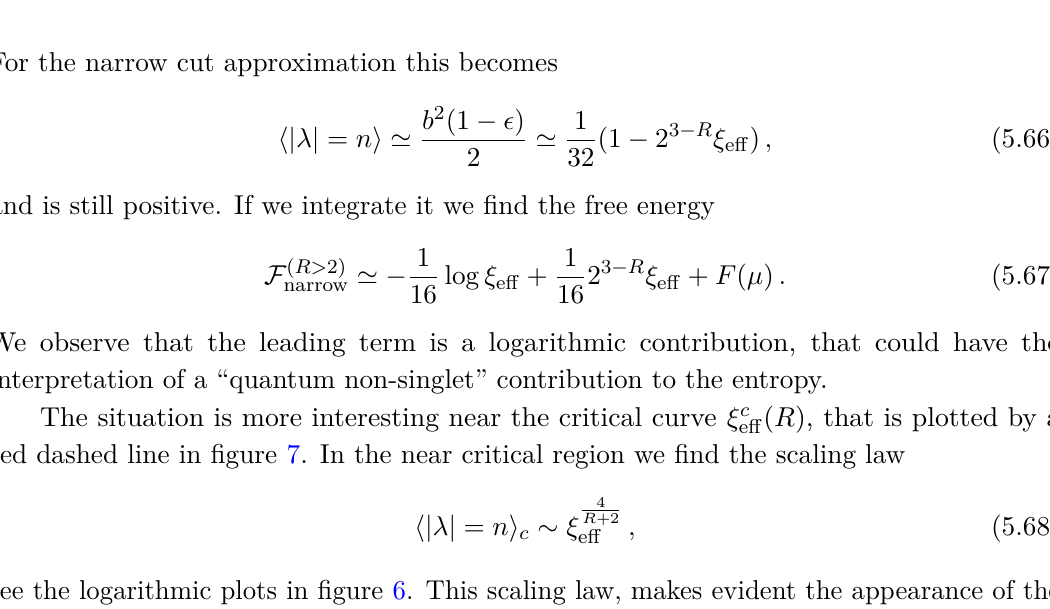
Figure 6 . Logarithmic plots of the number of boxes h n i (black line) for fixed R = (2 . 5 , 4 , 6) — from left to right — as a function of r . The plots start from its critical value r ( R ) . With the blue line c we depict the scaling ξ 4 and with red line the scaling ξ 4 . Since the plots are logarithmic we R +2 R − 2 only care about the slope of the functions (scaling law). We observe that the blue curve captures the correct scaling properties of h n i , but starts to deviate as we increase R , since r ( R ) → 1 , where c the correct scaling is given by the narrow cut scaling of eq. (5.66). The numerical prefactor shifts the plots vertically and can be determined for each R , so that the blue curve falls on top of the black one. Similar plots can be given if we keep r fixed and vary R